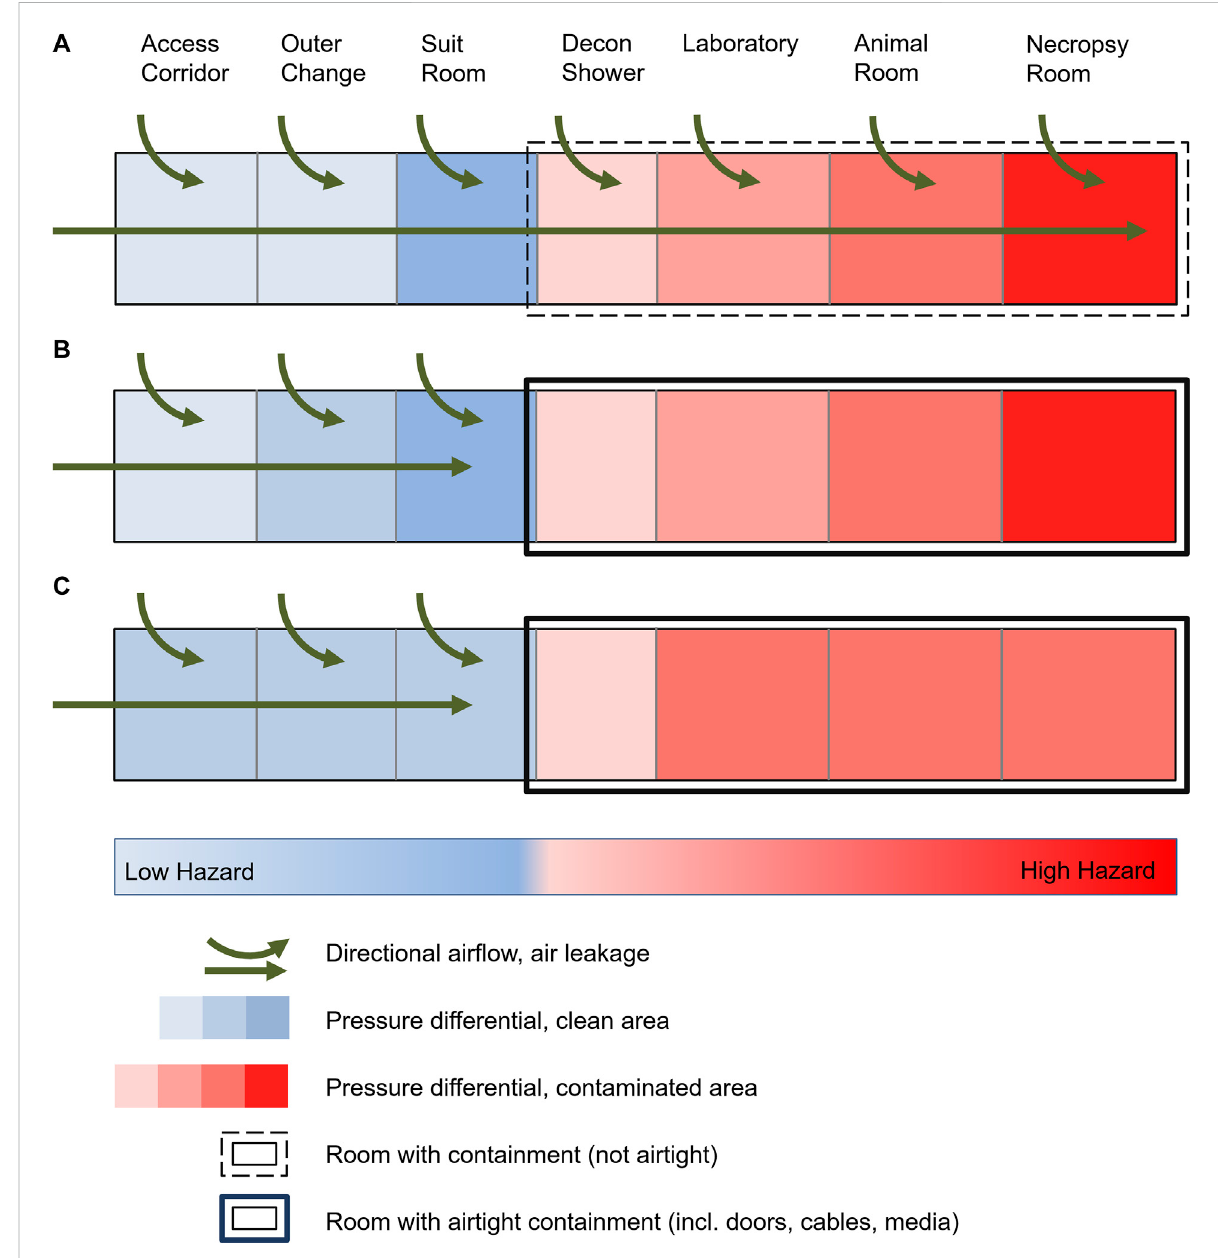
Schematicofahigh-securitylaboratorywithtargetedair fl owandpressuredifferentials. (A) Historicallaboratorieswithcommonleakagedueto standard construction practices, targeted air fl ow and pressure levels up to the area of greatest contamination. (B) Modern laboratories with technically airtight containment and maintenance of pressure levels up to the area of greatest contamination. (C) Risk assessment-based reduction in the number of pressure levels in a BSL-4 laboratory with airtight containment despite unchanged protection against cross-contamination and protection of the